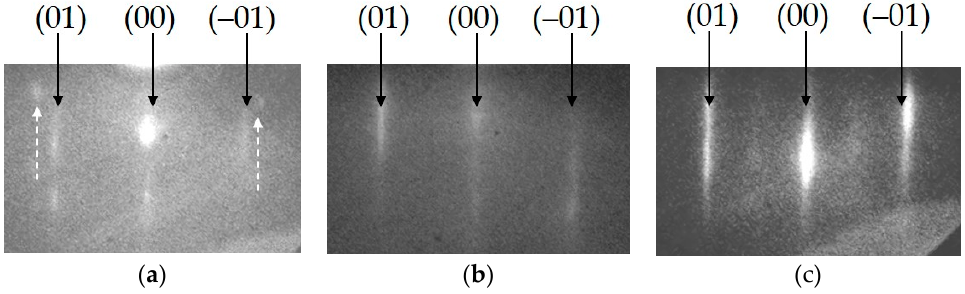
Figure 1. Evolution of reflection high energy electron diffraction (RHEED) patterns for different stages at onset of gas source molecular beam epitaxy (GSMBE). ( a ) The surface of (0001) AlN substrate at low temperatures. The (00), (01), and (–01) reflections from the (1 × 1) AlN surface and reflections from crystalline Al 2 O 3 islands are indicated by arrows; ( b ) (1 × 1) surface reconstruction of AlN exposed to ammonia; ( c ) (2 × 2) surface structure after deposition of about 20 pairs of short period superlattices (SPSLs).